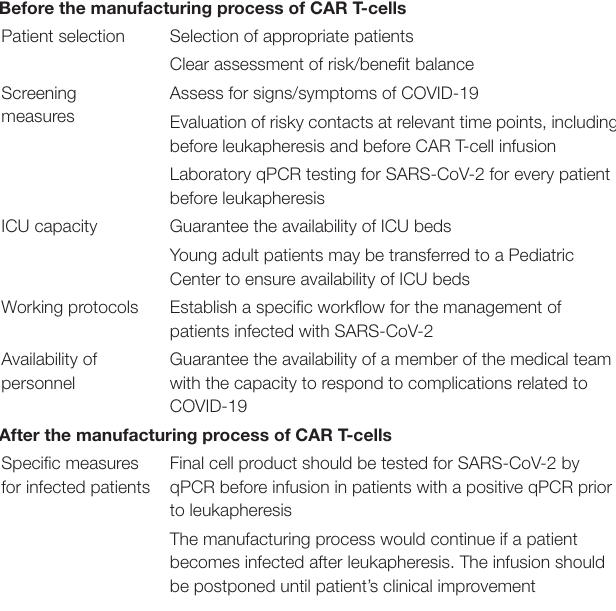
TABLE 1 | Practical aspects before and after the manufacturing process for the safe administration of an academic CAR T-cell therapy during the COVID-19